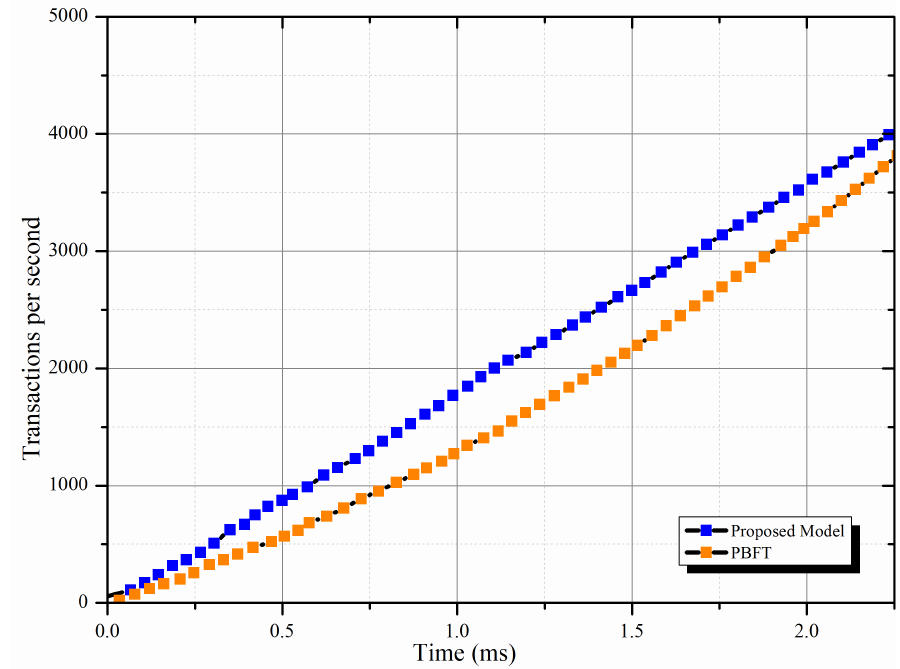
Figure 6. Relationship between TPS and